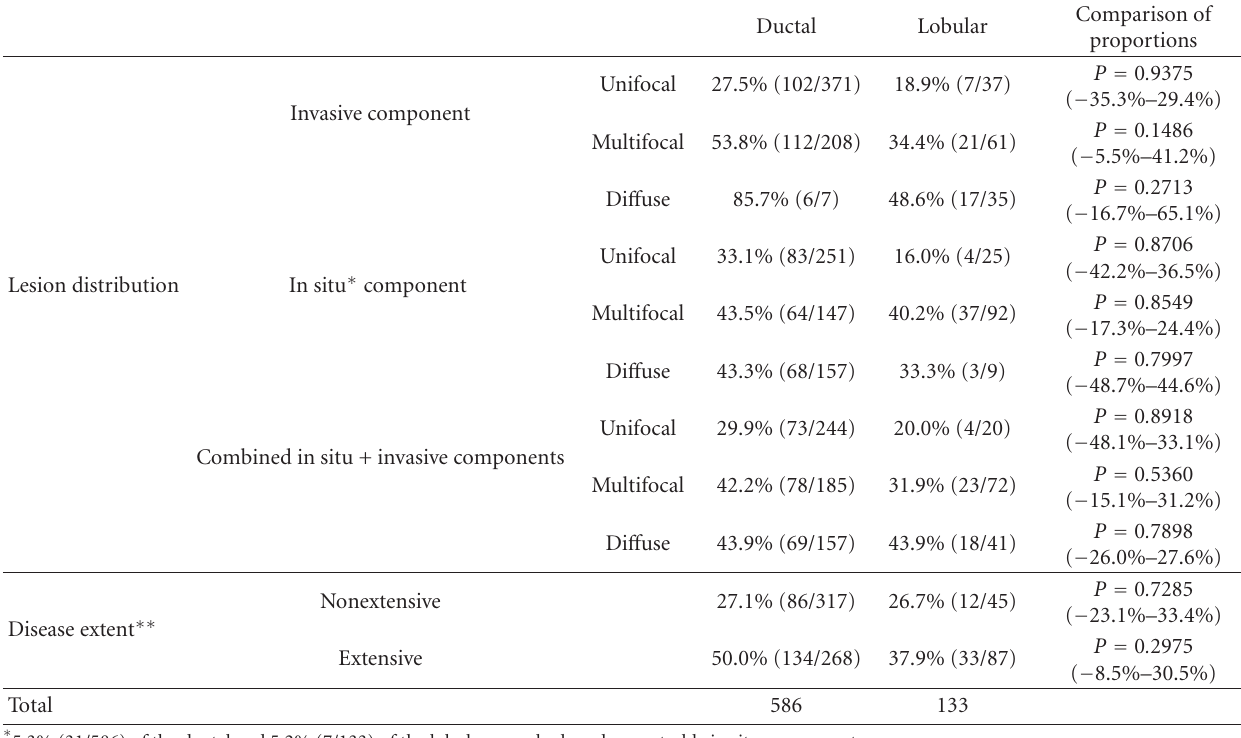
Table 2: Proportion of cases with lymph node metastases in ductal and lobular carcinomas by lesion distribution and disease extent,